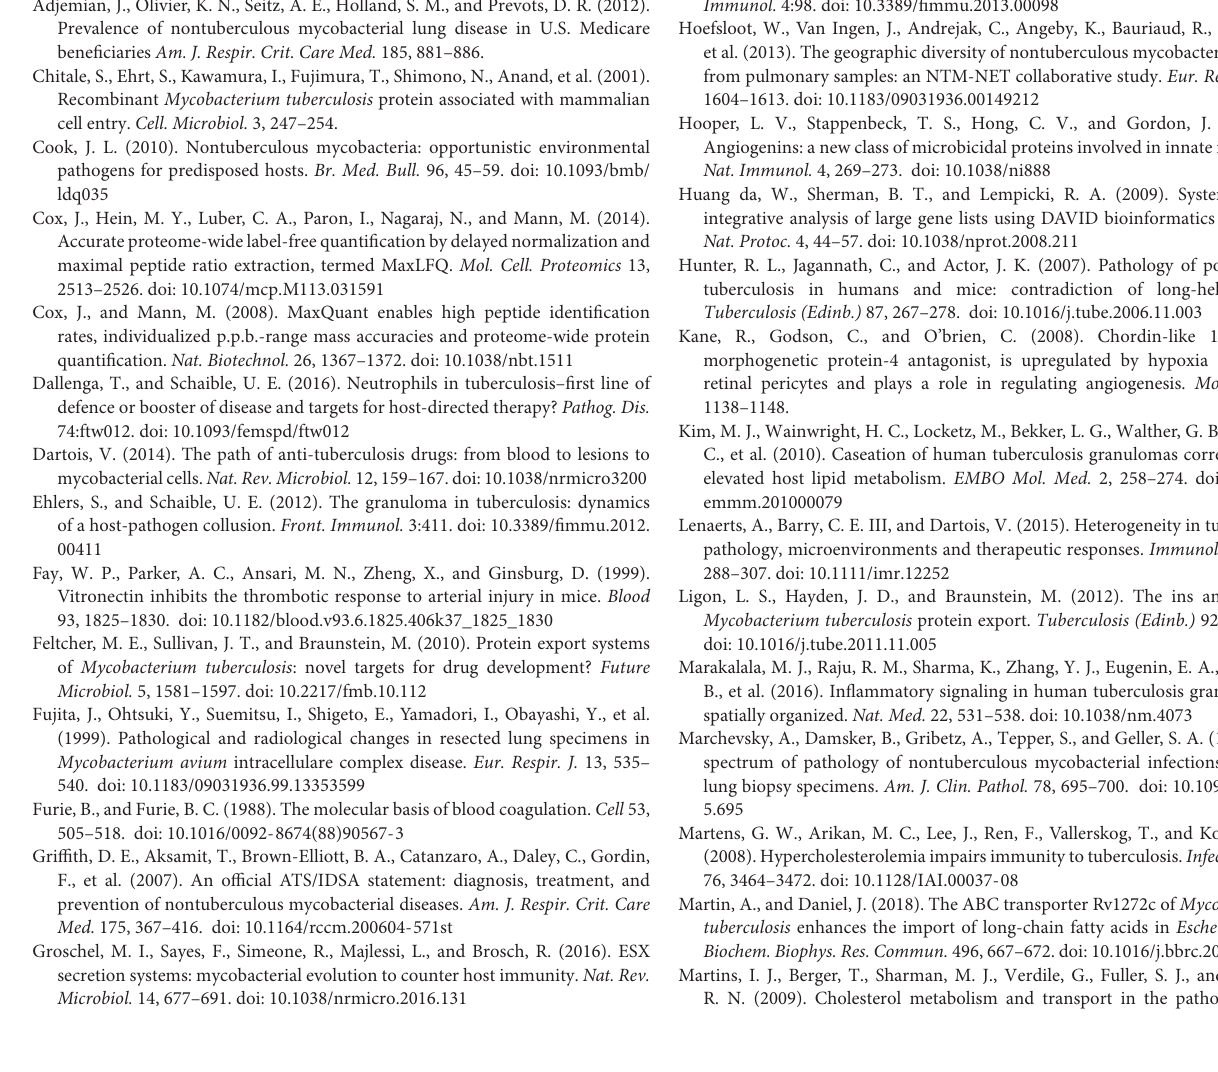
are plotted. Proteins with significantly different abundance between the caseous regions are highlighted. FIGURE S8 | Venn diagram illustrating the number of proteins in common among the present (This_study) and previously reported studies (Penn et al., 2018; Stamm et al., 2019). The gene lists for Stamm_2019 and Penn_2018 were reported by Penn et al. (2018) and Stamm et al. (2019). TABLE S1 | Excel file of the raw and imputed data of all proteomic analyses for identification of human, M. tuberculosis , and MAH proteins in mycobacterial granulomatous lesions. TABLE S2 | Identified M. tuberculosis proteins in TB granulomas. M. tuberculosis proteins significantly abundant in caseous or cellular sub-compartments of TB granulomas are listed. TABLE S4 | List of presumably secreted proteins of M. tuberculosis in Supplementary Figure S8